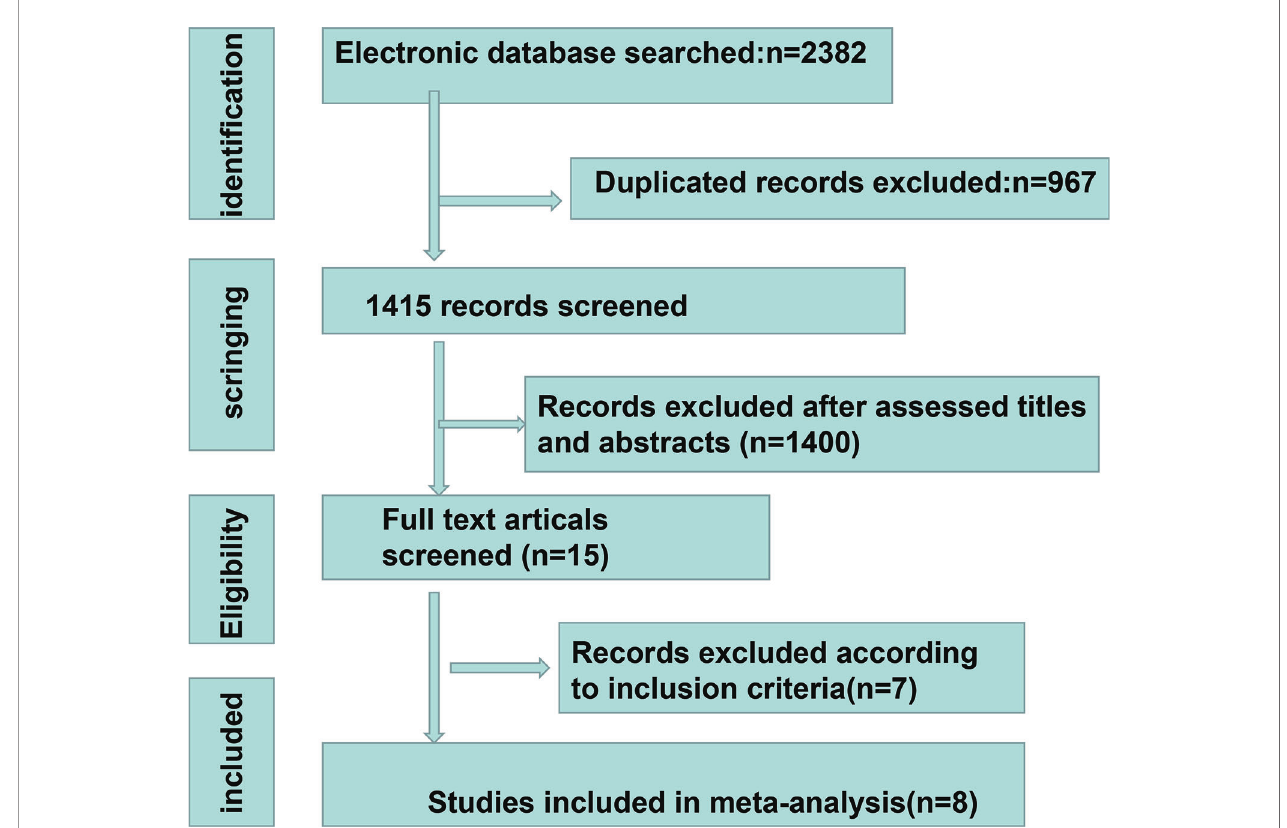
FIGURE 1 | The process of study